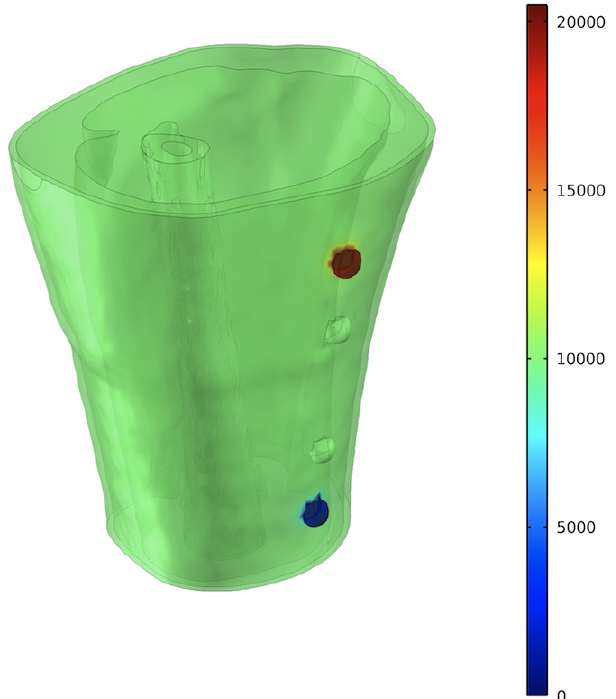
Fig. 25: Surface plot of potential generated by injecting 1 A through the CC electrodes.